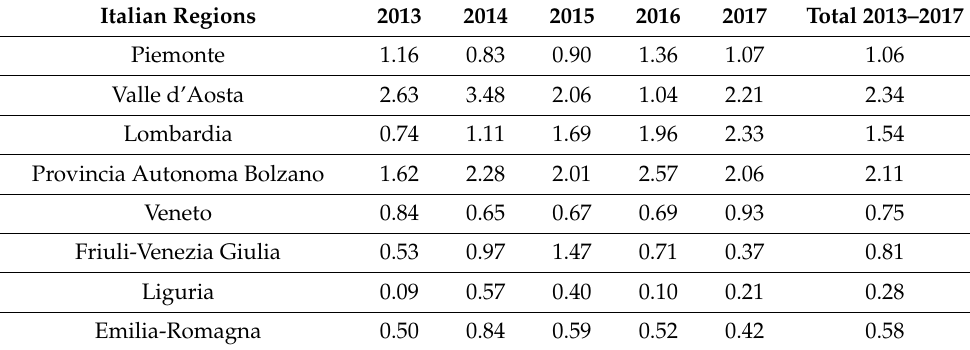
Table 3. Clubfoot incidence rate about regions who gave the